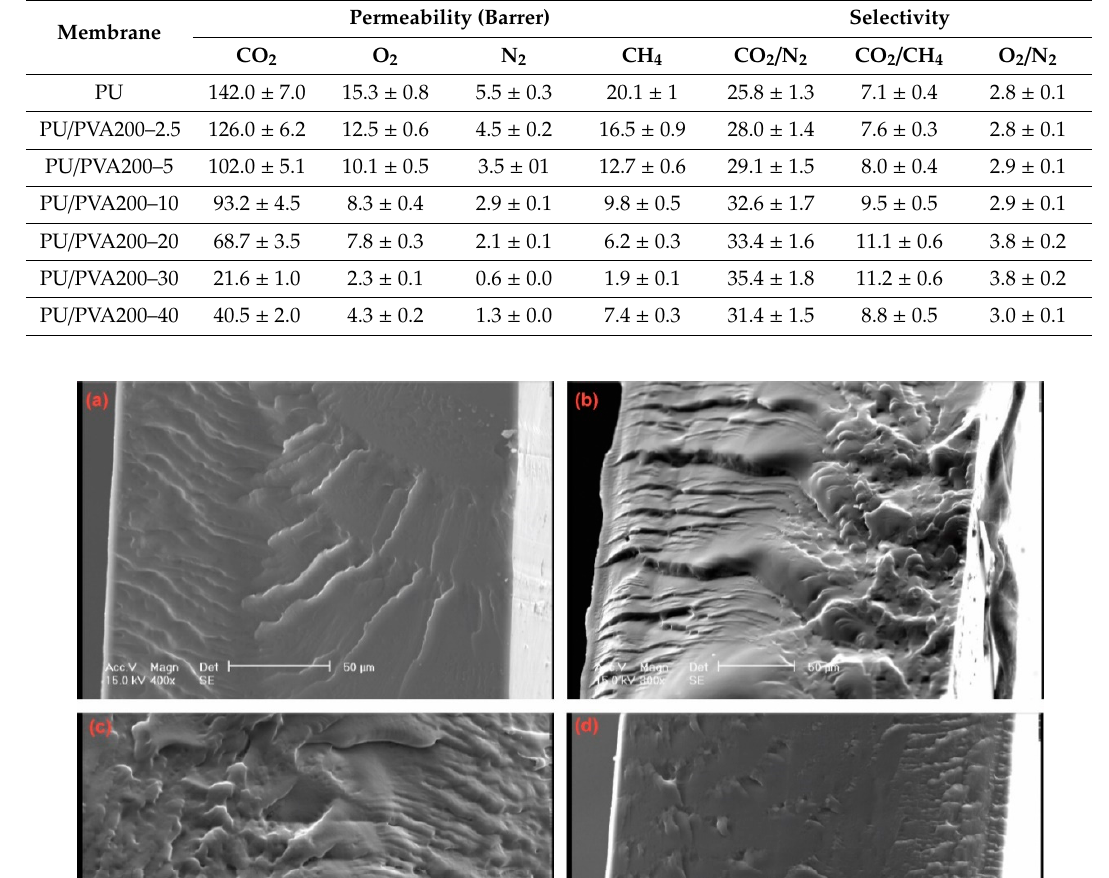
Table 1. Separation properties of CO 2 , O 2 , N 2 , and CH 4 through PU / PVA200 blends.